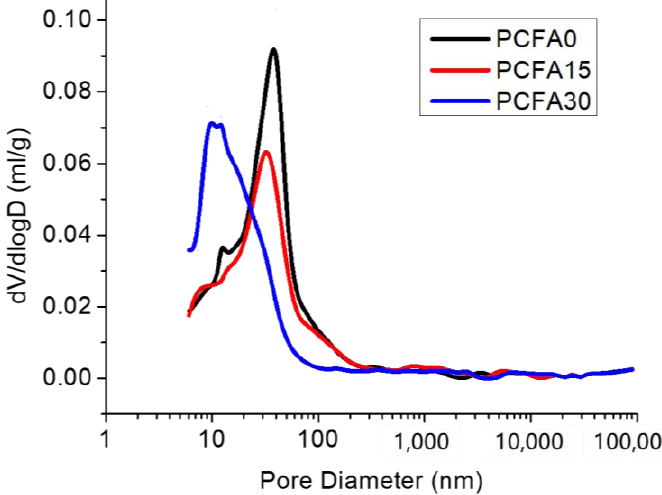
Figure 10. Pore size distribution after 90 days of curing.